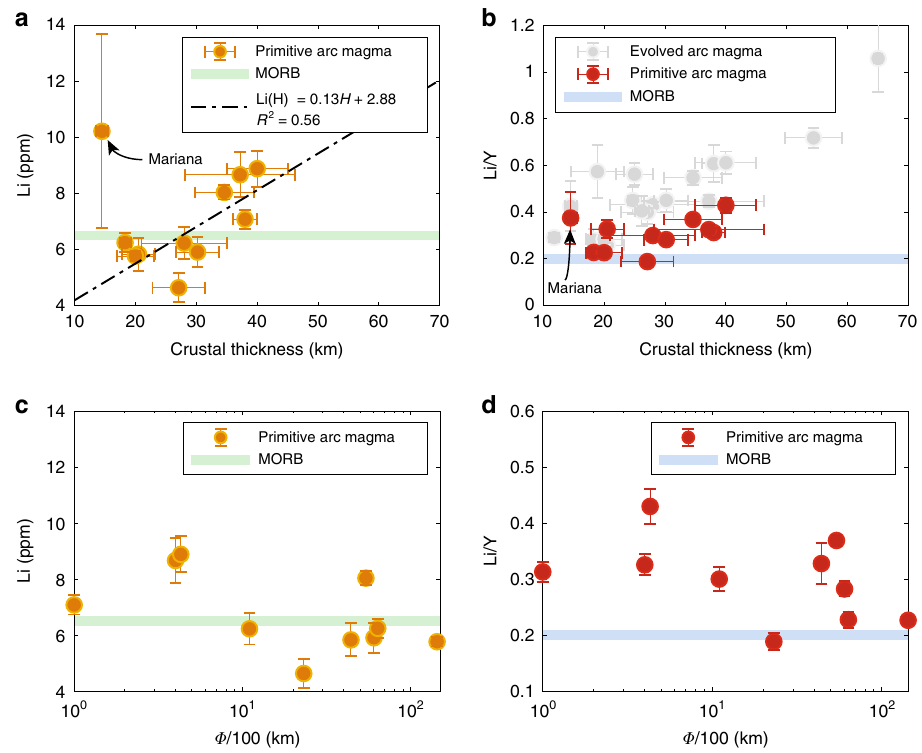
Fig. 3 Li systematics of primitive arc magmas versus crustal thickness and slab thermal parameter. a , b Li and Li/Y in primitive arc magmas vs. crustal thickness. Primitive arc magmas represent only those with 48 – 52 wt.% SiO 2 and 6 – 15 wt.% MgO. In ( b ), dull gray symbols represent averages for more evolved magmas (53 – 57 wt.% SiO 2 ). Error bars for Li concentration and Li/Y ratio are 2se; error bars for crustal thickness are one standard deviation (1 σ ) (Supplementary Dataset 2). As in Fig. 2, the pale green bar in ( a and c ) and blue bar in ( b and d ) show the average Li concentration of MORB from Gale et al. 22 and the Li/Y ratio of MORB from Ryan and Langmuir 9 , respectively. The dashed line in ( a ) represents the linear regression of the data (with the Mariana arc excluded). c , d Li and Li/Y of primitive arc magmas vs. slab thermal parameter ( Φ /100). Slab thermal parameters are from Syracuse et al. 34 .